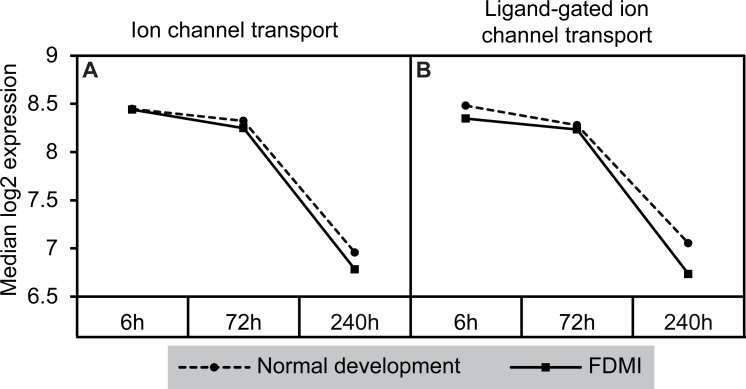
Median expression of pathways involved in ion transport during normal ocular development and in FDMI.Expression of the (A) Ion channel transport and (B) Ligand-gated ion channel transport pathways with significant expression shifts during FDMI (solid lines) compared to normal development (dotted lines) are shown. The ‘Ligand-gated ion channel transport pathway’ pathway was also significantly altered during normal development and was clustered with the neurotransmission pathway.